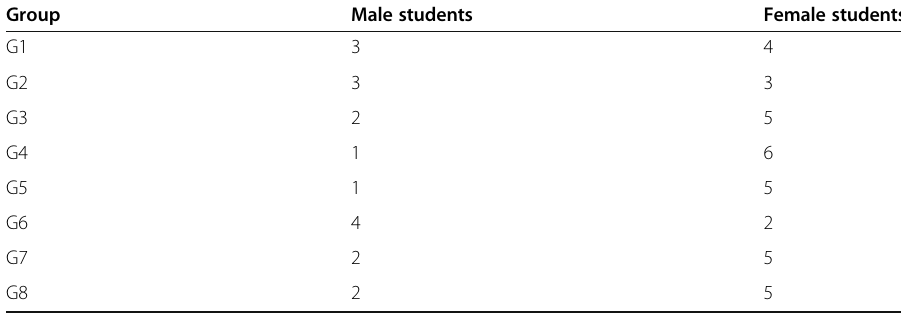
Table 3 Participants in group interviews Group